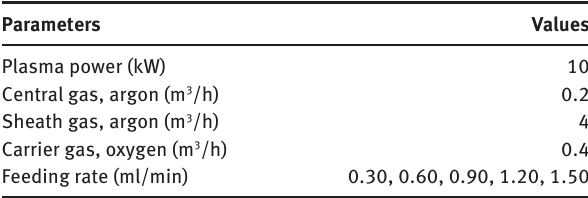
Table 1 Parameters of the thermal plasma deposition process. Parameters Values